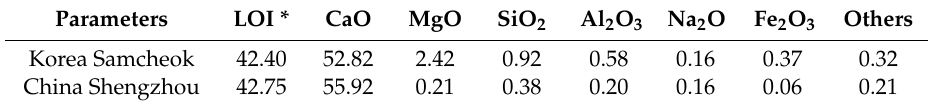
Table 3. The X-Ray Fluorescence (XRF) component analysis of the two kinds of limestone samples. Parameters LOI *